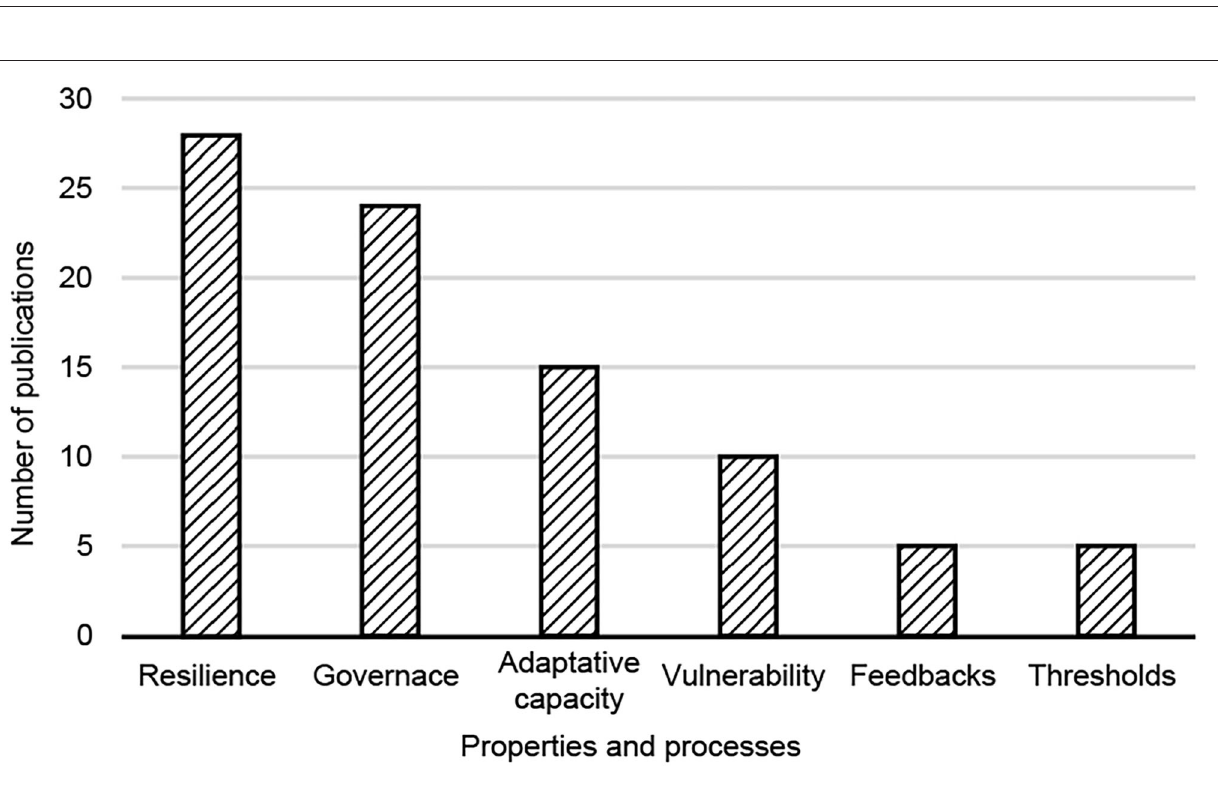
Frontiers in Marine Science |